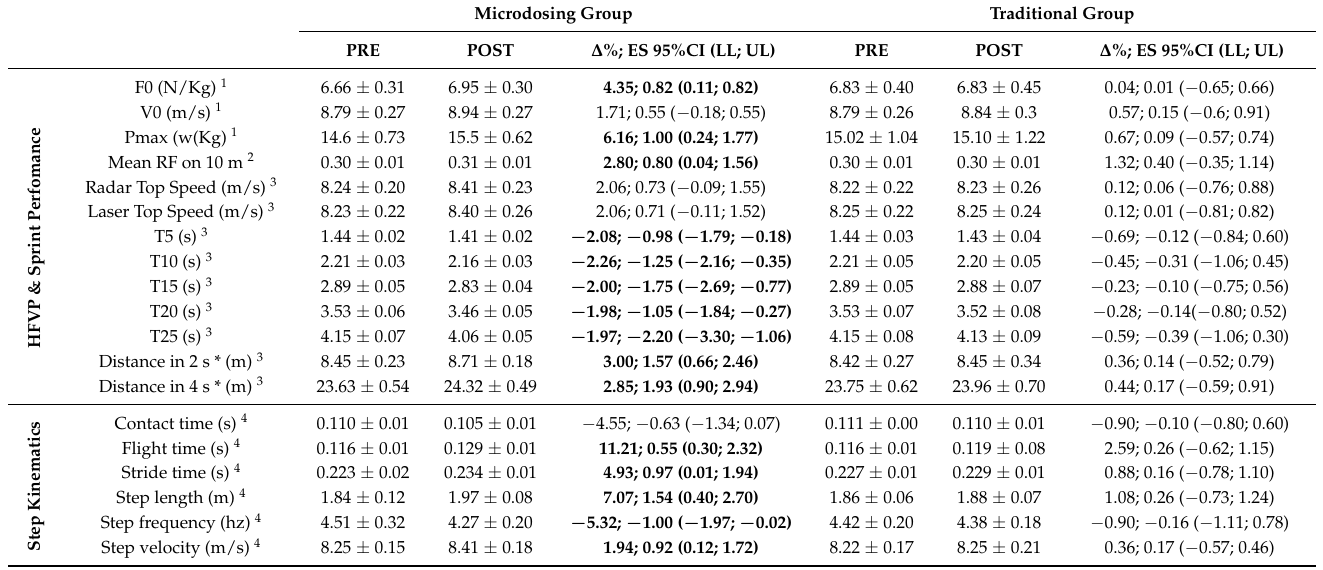
Table 2. Differences in Pre–Post data for microdosing (MG) and traditional (TG) training groups for physical qualities evaluated during the acceleration 1 , mechanical effectiveness 2 , performance parameters during the acceleration 3 and maximal speed kinematic stride characteristics 4